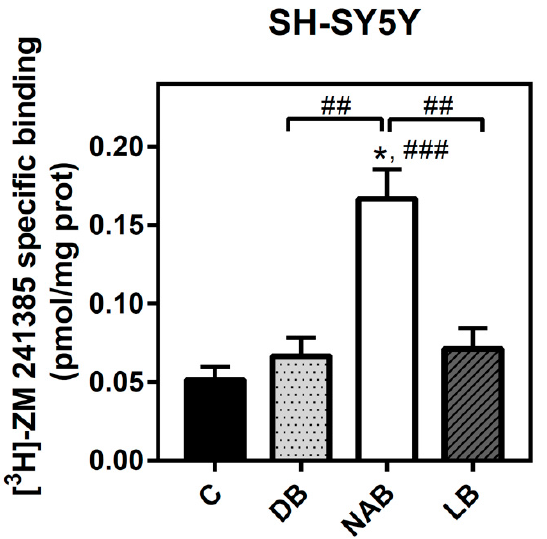
Figure 4. Analysis of adenosine A 2A receptors by radioligand binding assay in SH-SY5Y cells. Specific binding to A 2A receptor was determined in intact cells at saturating concentration (40 nM) of [ 3 H]-ZM 241385, as described in “Materials and Methods”. Nonspecific binding was determined in the presence of 12 mM theophylline. Treatments were performed for 24 h with DB, NAB, and LB extracts in SH-SY5Y cells. Data are means ± SEM of, at least, three independent assays; * p < 0.05 significantly di ff erent from their corresponding control (C) according to Student’s t test; ## p < 0.01 and ### p < 0.001, significantly di ff erent from control (C) or considered bars according to one-way ANOVA